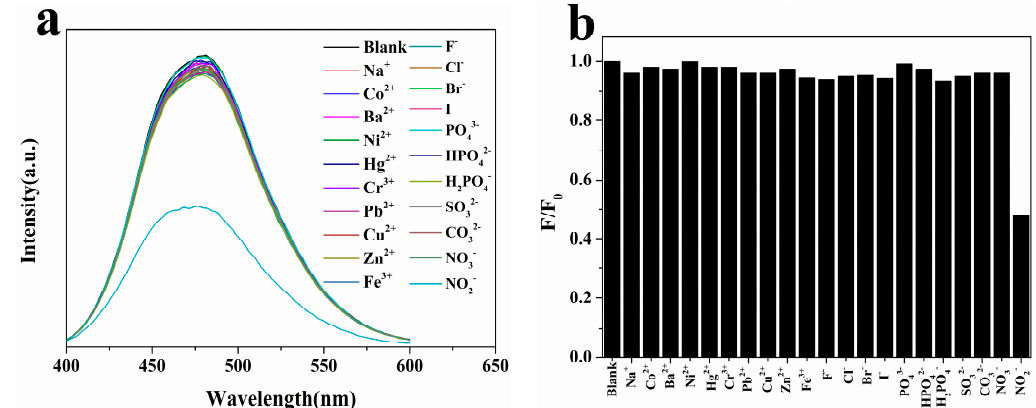
Figure 5. ( a ) Fluorescence spectra of the N-CQDs aqueous solution in the presence of different ions; ( b ) Fluorescence response of the N-CQDs aqueous solution in the presence of different ions at 480 nm.